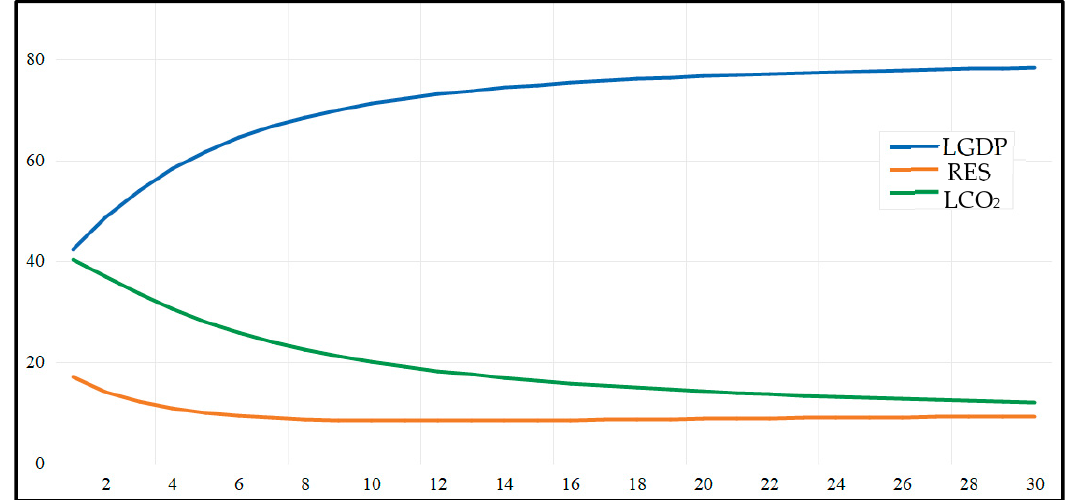
Figure 10. LCO 2 forecast error variance decomposition results. Energies 2020 , 13 , x FOR PEER REVIEW